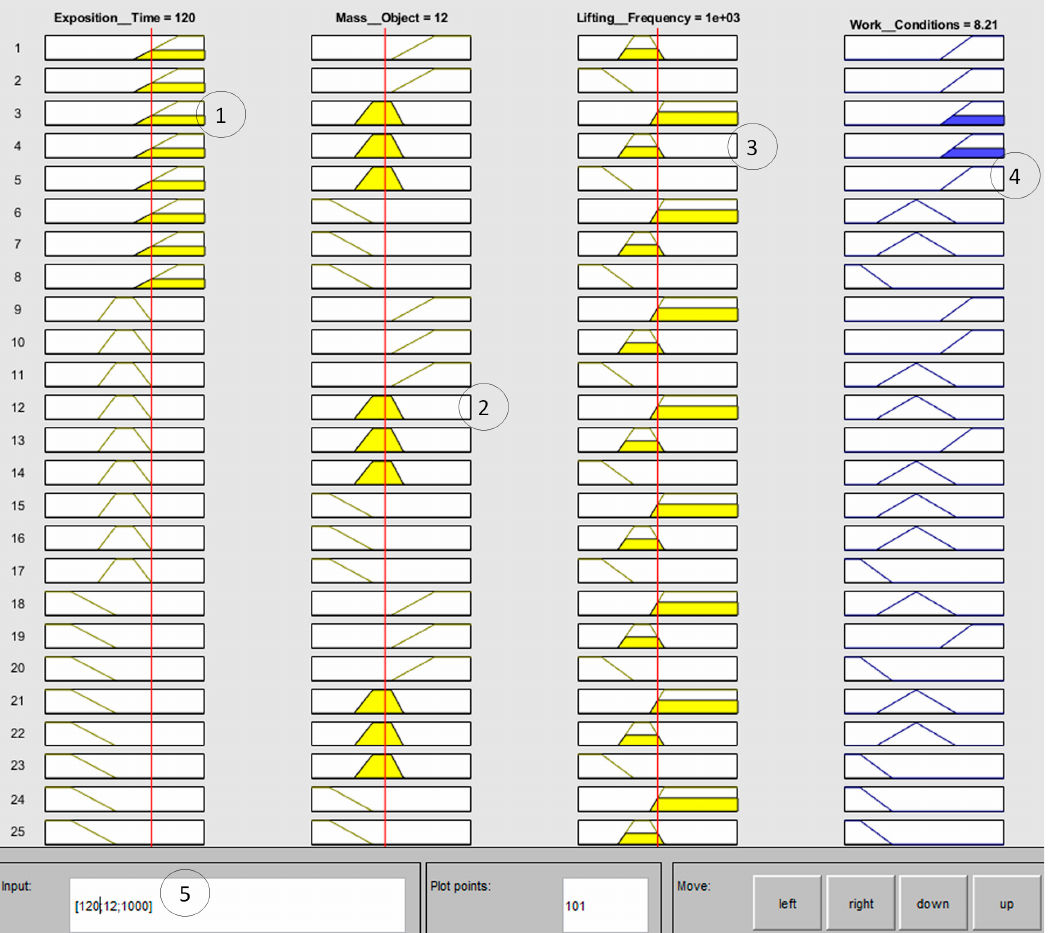
Figure 9. An example of the result showed in the Rule Viewer window. The highlighted rules are those applying to a specific work condition (1) High_Risk for Exposition_Time; (2) Medium_Risk for Mass_Object; (3) between Medium_Risk and High_Risk for Lifting_Frequency; (4) 8.21 for Work_Condition equivalent to High_Risk; (5) parameters entered 120 min, 12 kg, 1000